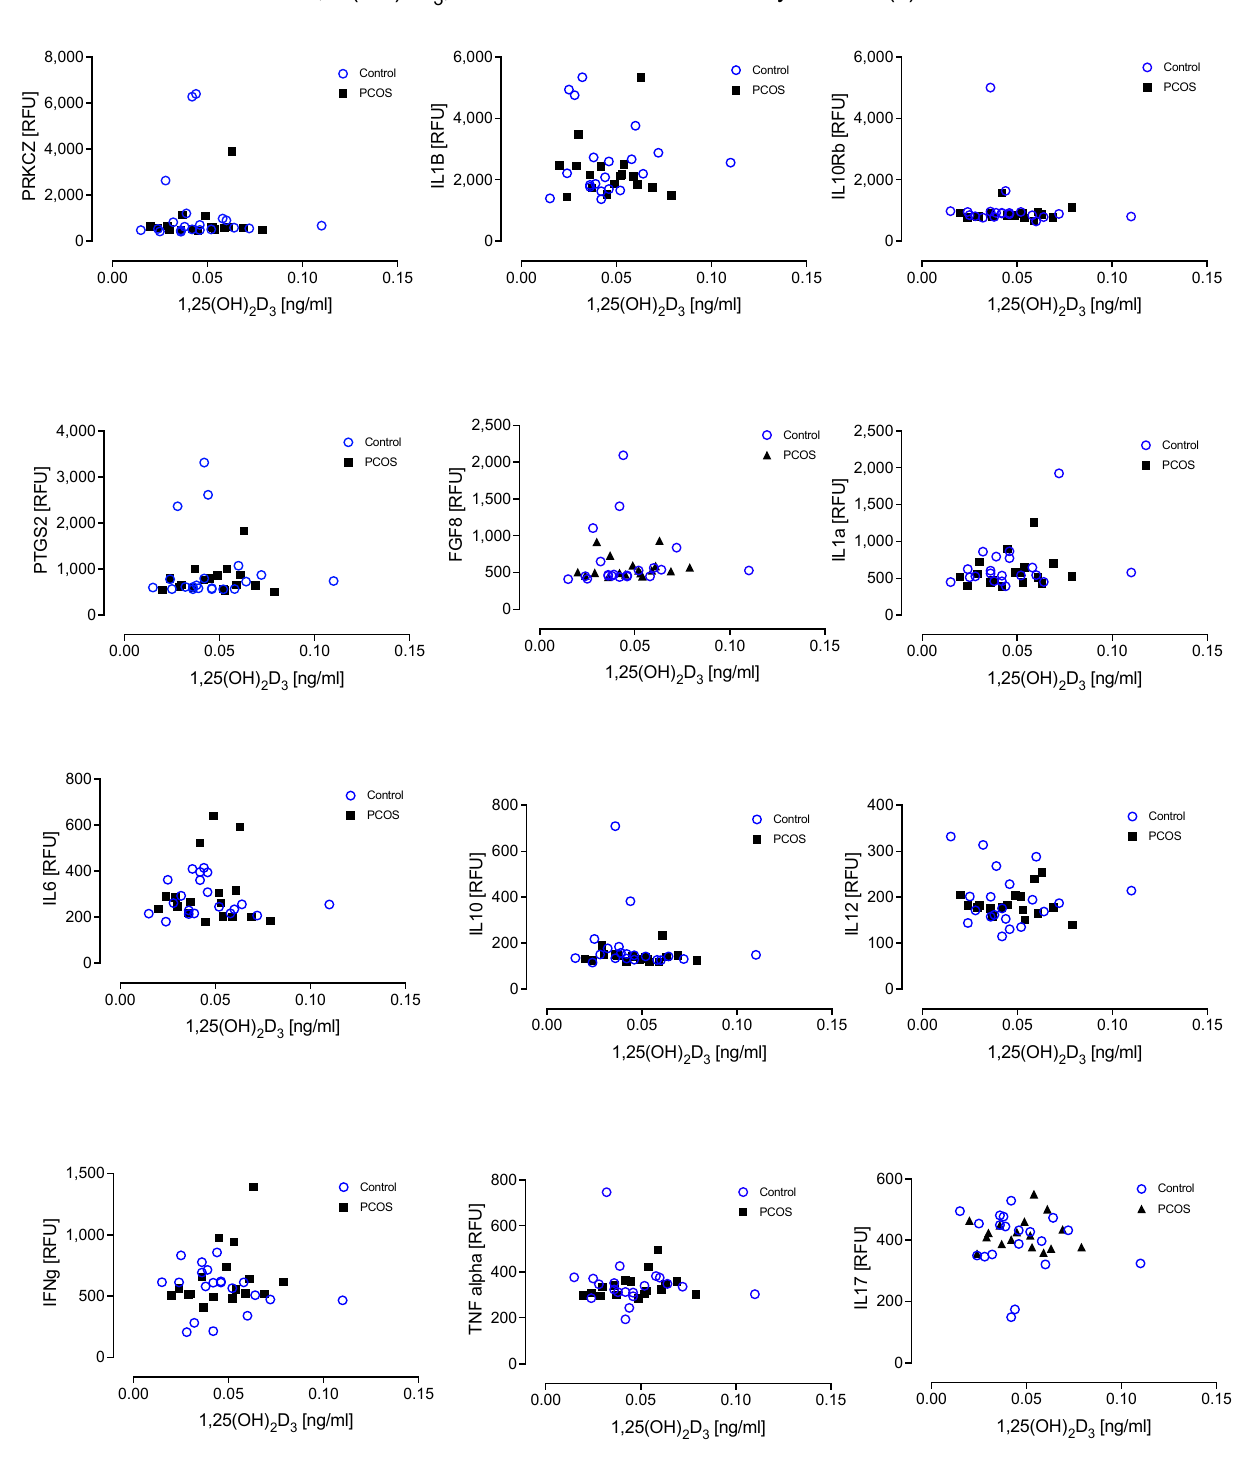
Figure 5. No relationship was found between 1,25(OH) 2 D 3 and the inflammatory markers Protein kinase C zeta type (PRKCZ), Interleukin-1 beta (IL1beta), Interleukin 10 receptor beta subunit (IL10Rbeta), Prostaglandin G/H synthase 2 (PTGS2), Fibroblast growth factor 8 (FGF8), Interleukin-1 alpha (IL1alpha), IL6, IL10, IL12, Interferon gamma (IFN-g), Tumour necrosis factor alpha (TNF-a) and